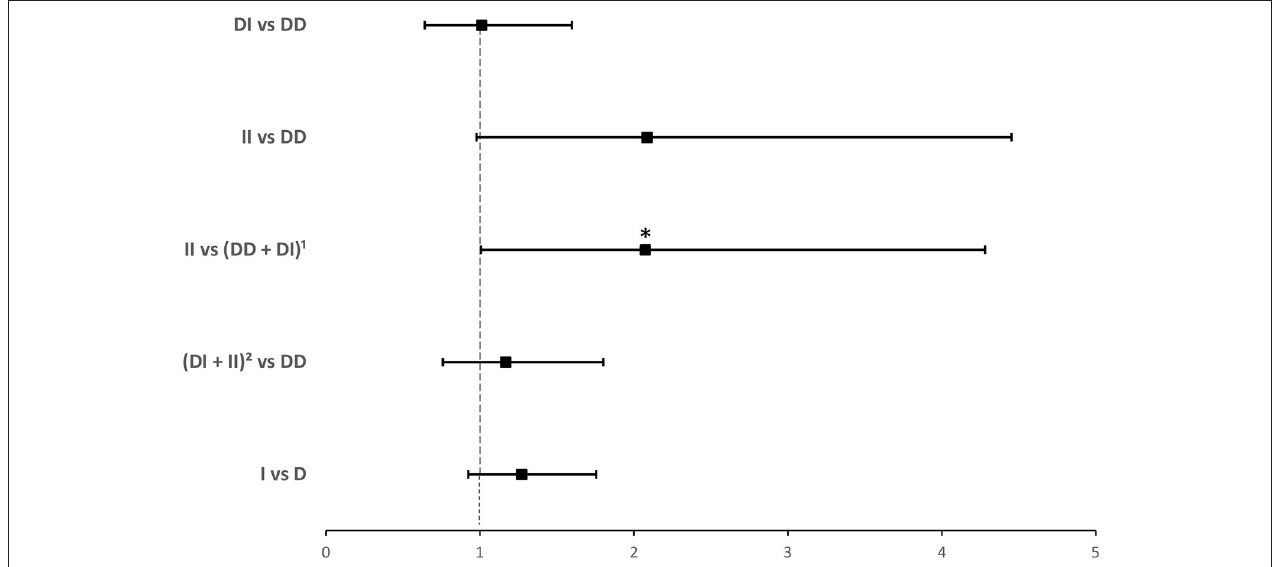
FIGURE 1 | Forest plot showing adjusted odds ratios ± 95% confidence intervals of ACE1 polymorphism for contracting SARS-CoV-2. Multivariate analysis included variables that were statistically significant in the association analysis shown in Table 1 ; * P < 0.05. 1 D allele carriers. 2 I allele